Question: Author a descriptive caption for the visualization shown.
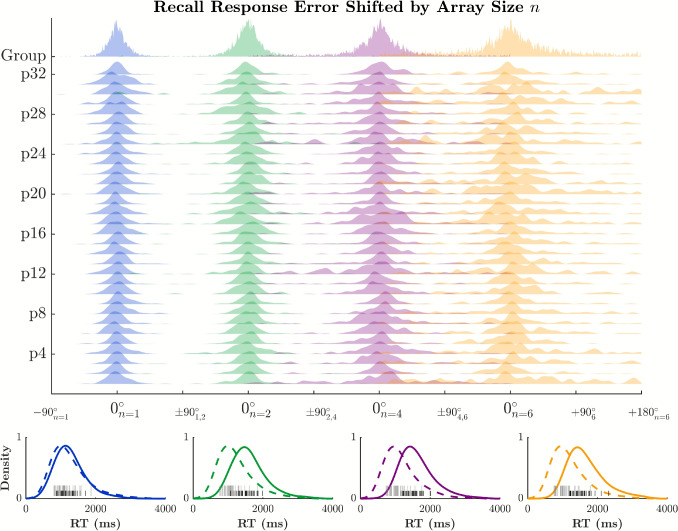
Answer: Top: Target-centered (0 \documentclass[12pt]{minimal} \usepackage{amsmath} \usepackage{wasysym} \usepackage{amsfonts} \usepackage{amssymb} \usepackage{amsbsy} \usepackage{mathrsfs} \usepackage{upgreek} \setlength{\oddsidemargin}{-69pt} \begin{document}$$^{}\circ$$\end{document} ) response error in degrees for array sizes ( n ) 1, 2, 4 and 6. The y-axis shows individual participant’s (p) probability kernel densities, the top row shows aggregate histograms calculated across individuals to illustrate the increasingly heavy-tailed spread in precision as array size increases. Bottom: Participant averaged response time kernel densities for array sizes 1, 2, 4 and 6 (left to right) in the recall task (solid lines) and recognition task (dashed lines). Recall median RTs (black) and recognition median RTs (gray) are shown for each individual. The resulting ex-gaussian shape is typical in decision-making tasks and found across individuals